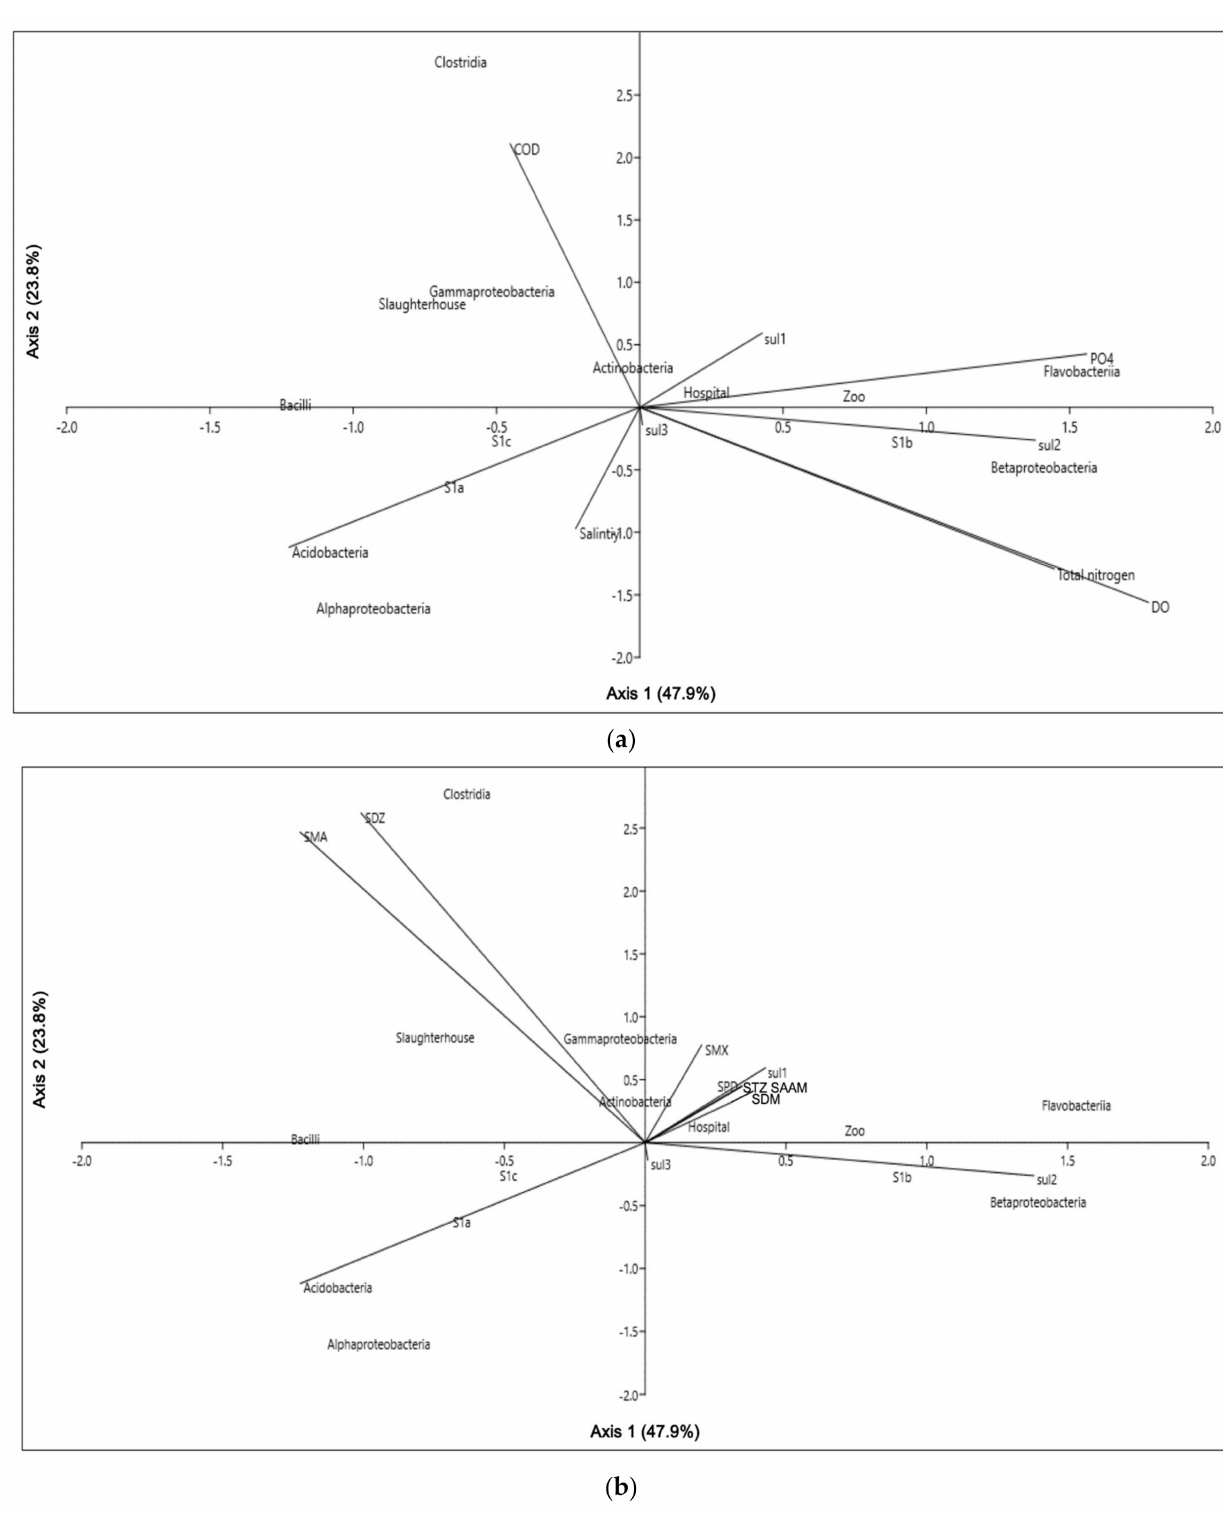
Figure 4. Canonical correspondence of relationships between the dominant class and total sul genes with ( a ) environmental physicochemical parameters and ( b ) SAs